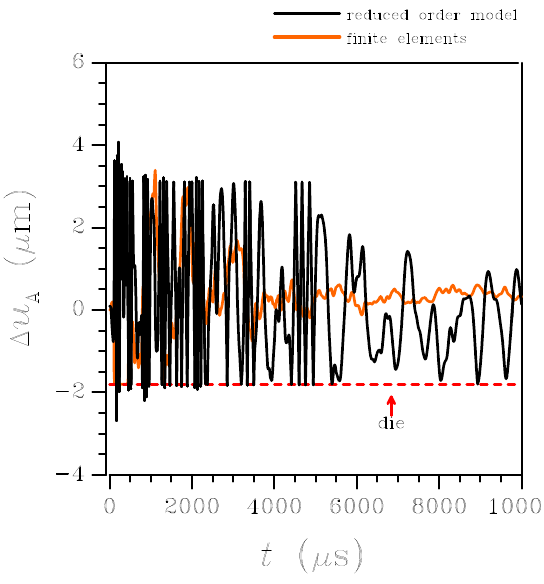
Figure 7. High- g test: time evolution of the relative displacement ∆ u (see Figure 1). Comparison between FE and ROM